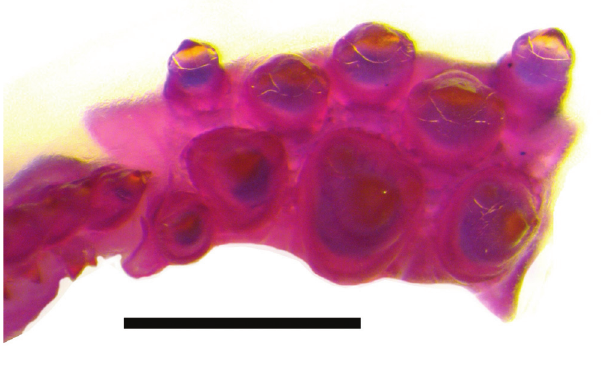
Fig. 3. Premaxilla of Carlastyanax aurocaudatus , CI-FML 5015, 44.4 mm SL, ventral view, medial to right. Scale bar = 1